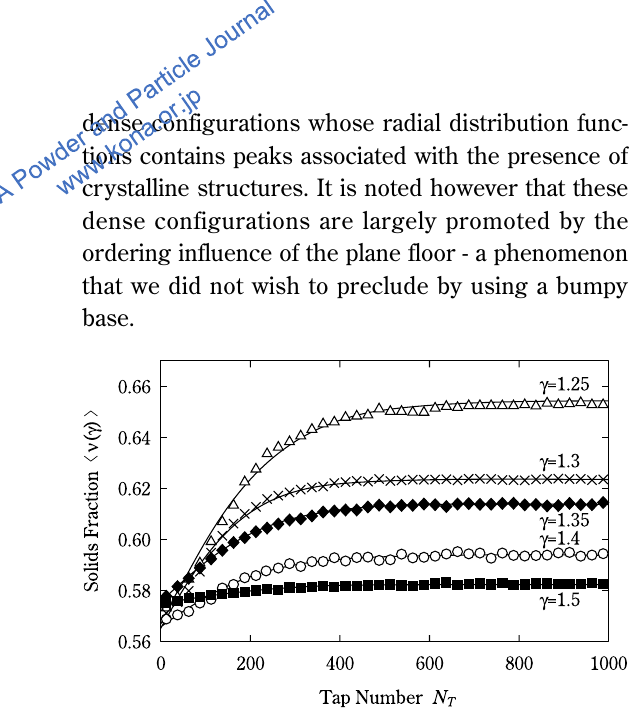
Fig. 5 Evolution of the ensemble-averaged bulk solids fraction 〈ν ( n ; γ ) 〉 for tap intensity γ＝ 1.25( Δ ), 1.3( × ), 1.35( ♢ ), 1.4( ), 1.50( * ). This demonstrates the effect of increasing γ on 〈ν ( n ; γ ) 〉